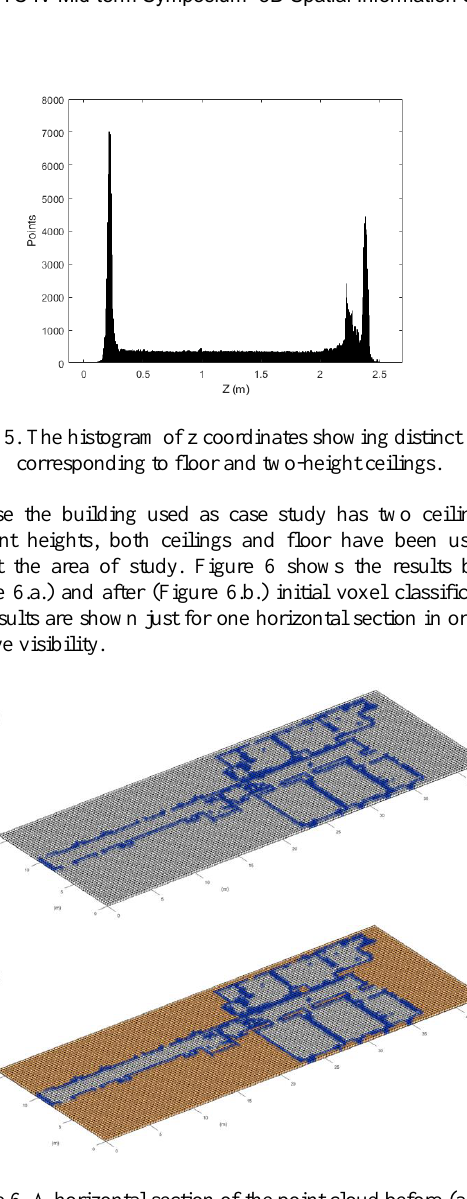
Figure 6. A horizontal section of the point cloud before (a) and after (b) initial voxel classification. Voxels are represented in blue (occupied), white (empty) and exterior (orange).